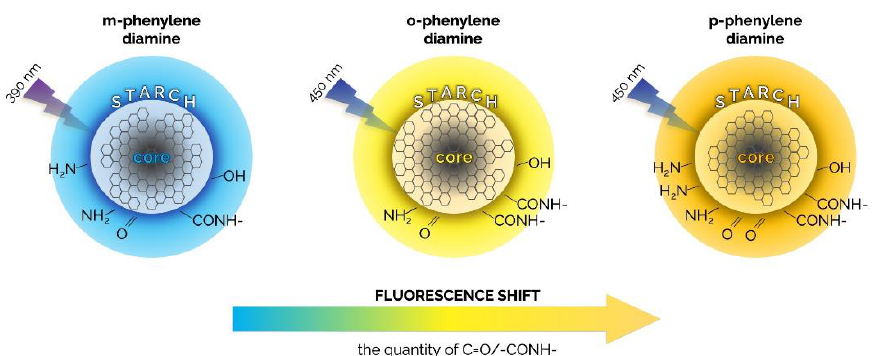
Figure 10. Sketch showing the fluorescence mechanisms of m-PD, o-PD, p-PD embedded in starch.